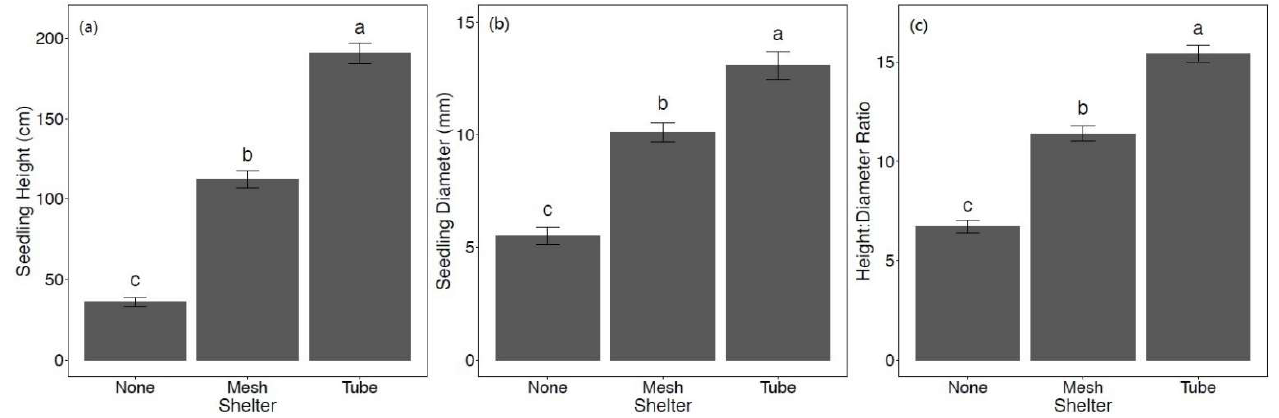
Figure 4. Mean ± SE ( a ) height (cm), ( b ) diameter (mm), and ( c ) height:diameter ratio of Quercus virginiana seedlings after the second growing season (February 2021). Seedlings either had no tree shelter, a mesh tree shelter, or solid-wall tube tree shelter. Different letters indicate significant differences among the shelter treatment levels (α = 0.05).